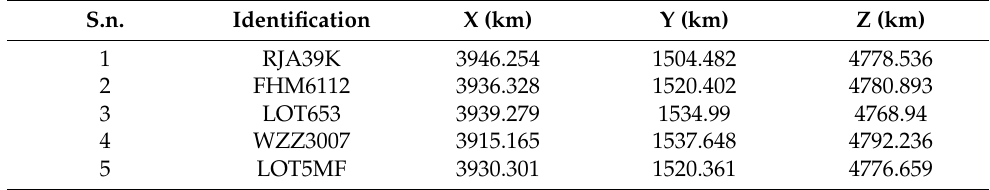
Table 2. Initial coordinates in